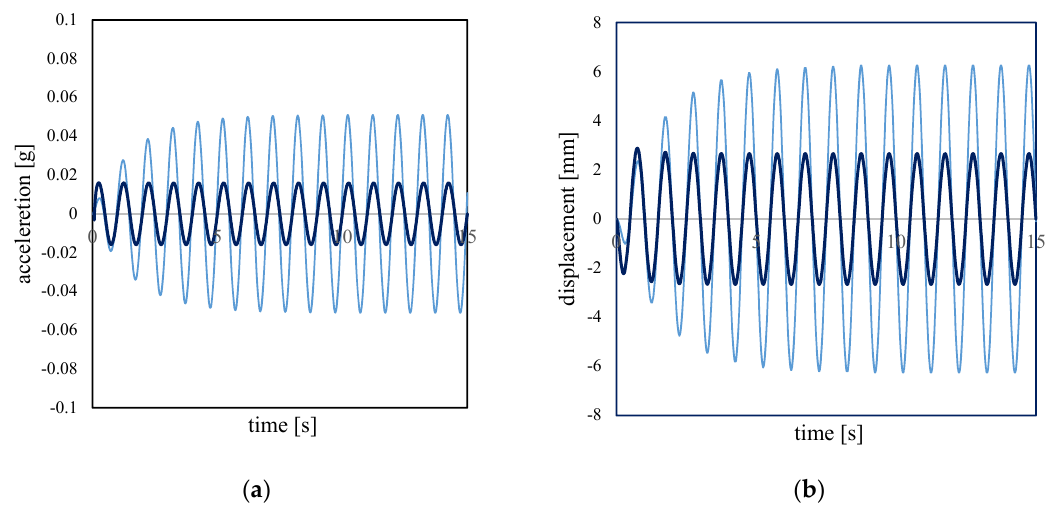
Figure 3. Relative acceleration ( a ) and displacement ( b ) respectively of bare single degree of freedom (SDOF) structure (BS—light blue line) and viscous damped SDOF Structure (DS—deep blue line) subjected to sinusoidal force.